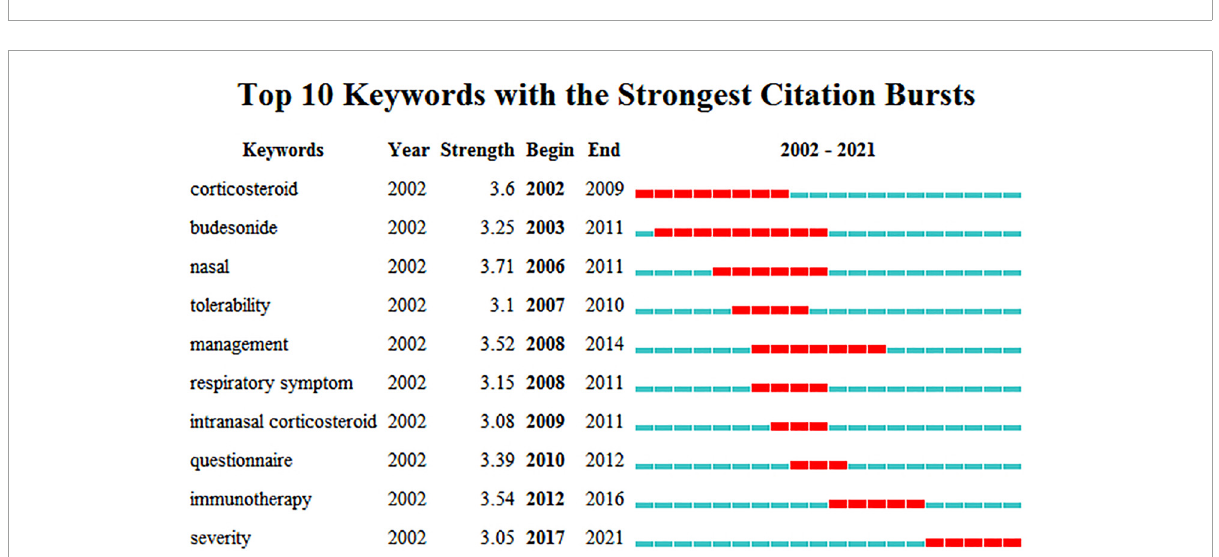
FIGURE8 Time-line map of keyword clusters.